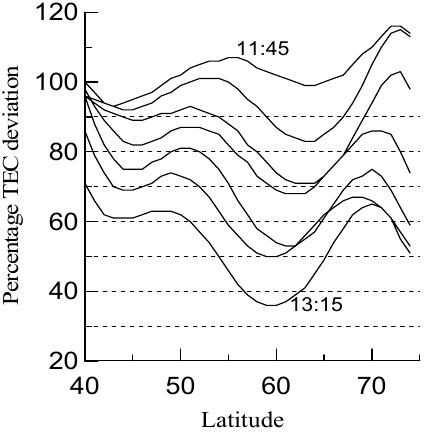
Fig. 7. The 15min latitude profiles of TEC ratios with respect to the quiet time for period of 11:45–13:15UT, 12 September 1999. Each curve is shifted downwards by 20TECU.